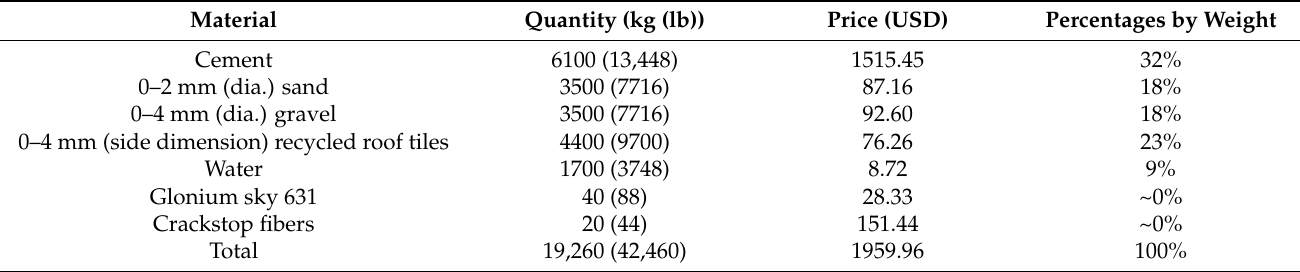
Table 1. COBOD Mortar Mix Material Table [24]. Adopted from [24]. Table was recreated with rounded numbers and unit conversions from